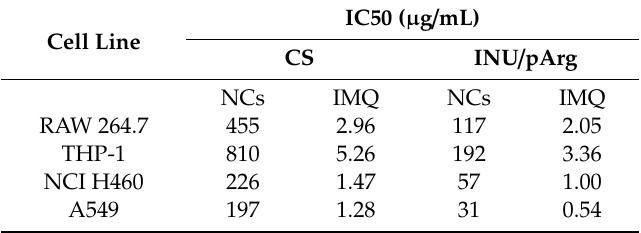
Table 3. Half-maximum inhibitory concentration (IC50) values of IMQ-loaded CS and INU / pArg nanocapsules in four di ff erent cell lines incubated with the nanocapsules for 24 h. The corresponding IMQ concentration is also indicated. CS: Chitosan, IMQ: Imiquimod, INU: Inulin, pArg: